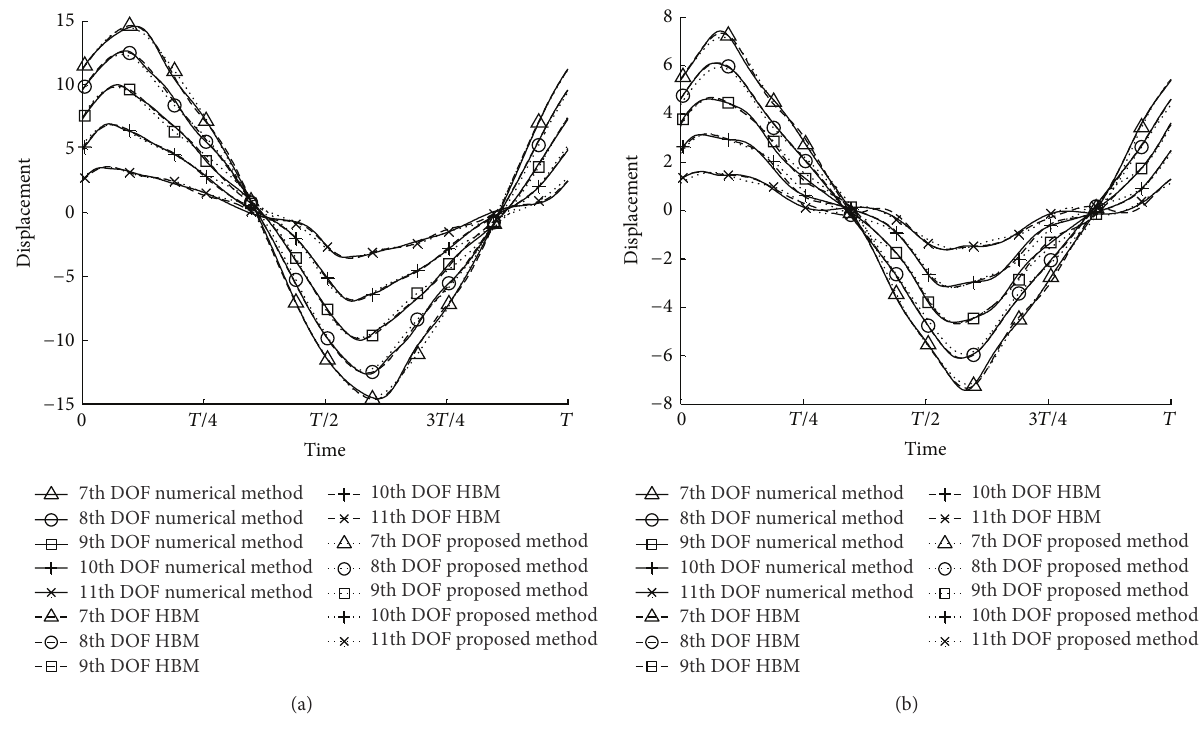
Figure 3: Time response of nonlinear systems at their resonance: (a) weakly nonlinear system 𝜔 ∗ = 1.21 ; (b) essentially nonlinear system 𝜔 ∗ = 1.36